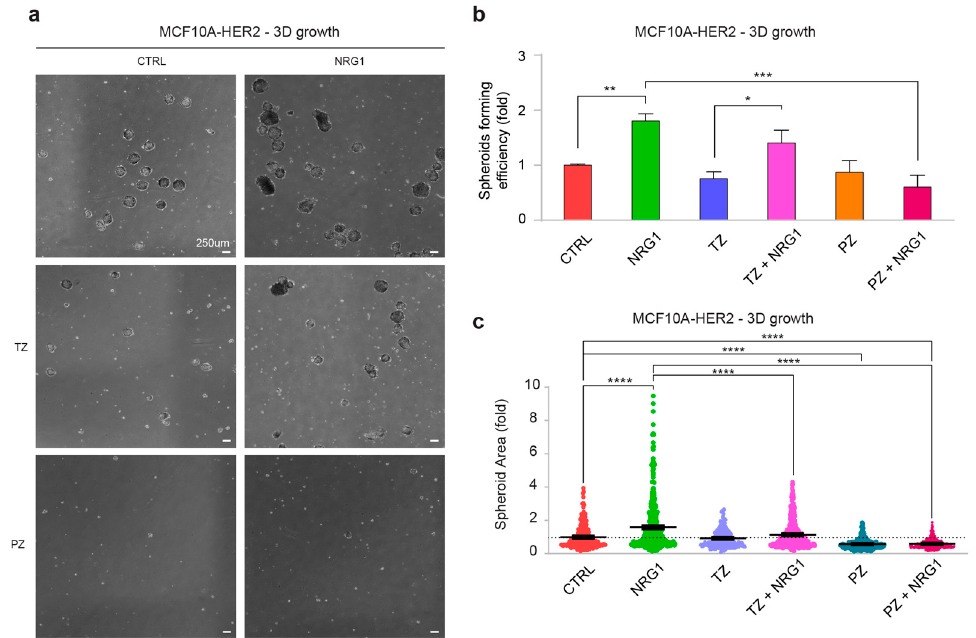
Figure 7. Administration of NRG1 β promotes growth in non-adherent conditions in basal-like/triple- negative breast cells engineered with HER2 overexpression. ( a – c ) Spheroid forming efficiency and growth (size) of HER2-overexpressing MCF10A (MCF10-HER2) upon stimulation with NRG1 β . MCF10A cells were seeded in ultra-low attachment plates and stimulated with/without NRG1 β (10 ng/mL), trastuzumab (TZ, 10 µ g/mL) or pertuzumab (PZ, 10 µ g/mL) every 3 days up to 14 days. Representative pictures of spheroids are provided in ( a ); spheroids number (spheroid forming efficiency) and size are provided in ( b , c ), respectively. In all panels, numerical data are normalized to control cells and presented as mean (error bars show s.e.m.); statistical significance was determined using one-way ANOVA followed by Tukey’s test in ( b , c ); * p < 0.05, ** p < 0.01, *** p < 0.001, and **** p < 0.0001.